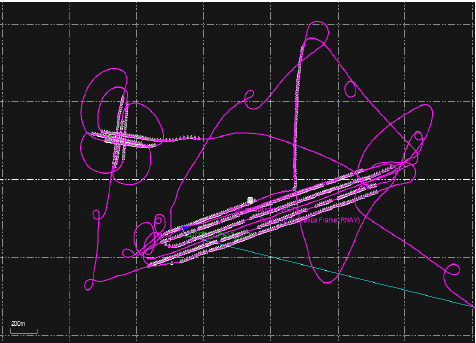
Figure 4: Trajectory of the flight. The clover leaf pattern in the NW represents the calibration flight. The 360° turns are performed after certain time to limit the drift in heading.